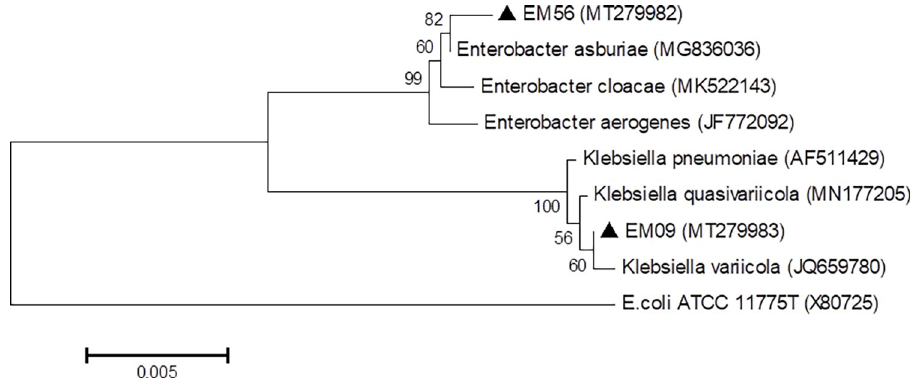
Fig 1. Phylogenetic tree of the bacteria Enterobacter asburiae strain EM09 and Klebsiella variicola strain EM56 based on sequencing of the 16S rRNA gene. The analysis contained 9 nucleotide sequences with 1,354 positions in the final data set. The Escherichia coli sequence was used as an external group. The scale bar represents approximately 5 base substitutions per 1000 nucleotide positions.